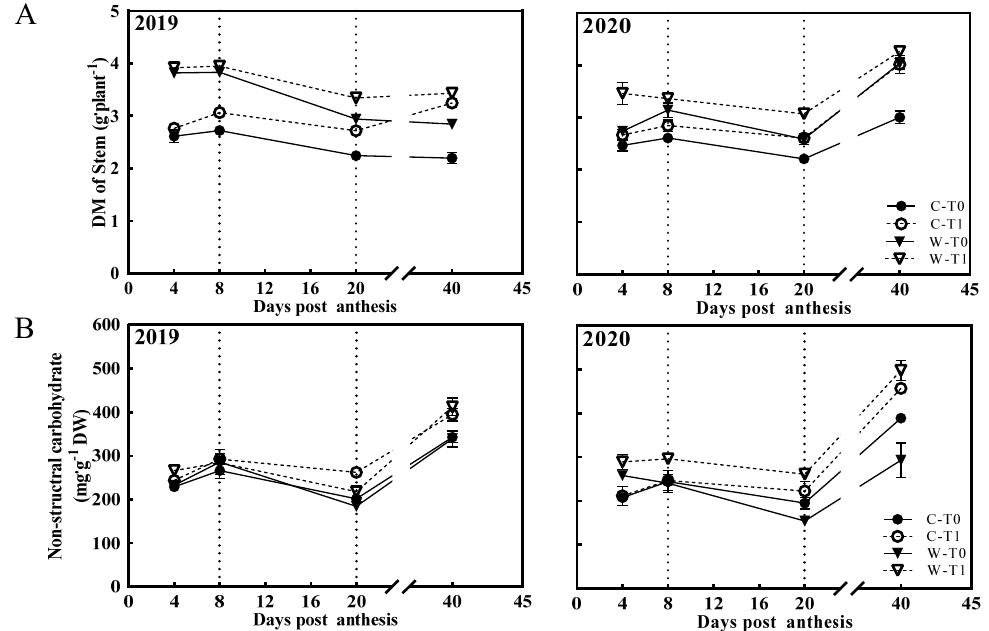
Figure 2. DM weight and NSC content of stems during grain filling. ( A ) DM weight of stem; ( B ) NSC content of stem; C, CJ03; W, W1844; T0, control group; T1, top 2/3 of the spikelets were removed. Vertical bars represent mean values ± SE ( n =